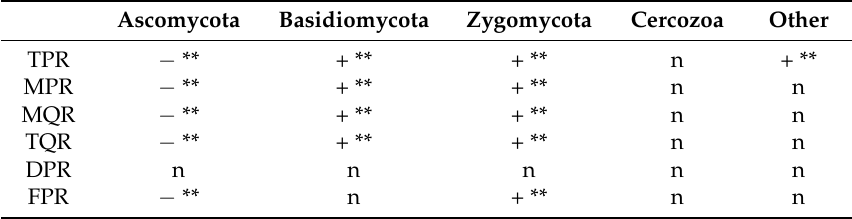
Table 2. Correlation coefficients between soil organic carbon accumulation and fungi taxa abundance in each sample group.